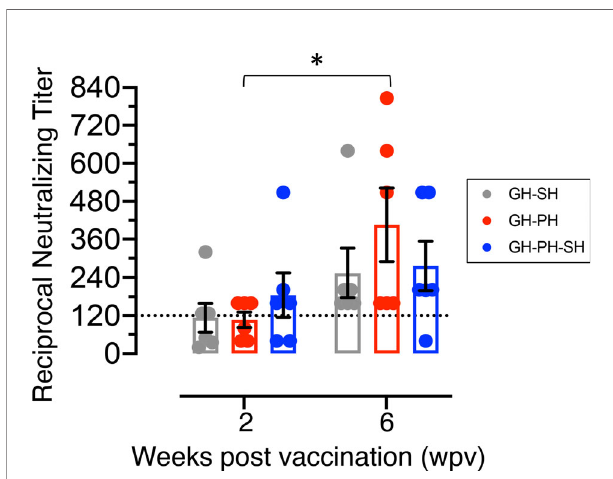
FIGURE 9 | Mean neutralizing antibody titers (mean ± standard error) of rhesus macaques vaccinated with canine distemper and measles vaccine were shown for GH-SH, GH-PH and GH-PH-SH groups. GH-PH animals demonstrated the highest neutralizing antibody response compared to the other groups at 6 weeks post vaccination (wpv). In contrast, GH-SH animals generated the lowest neutralizing antibody titers at 6 wpv, however the differences in responses were not statistically signi fi cant. Note, one animal from GH-PH-SH group had lower level of protective immunity (neutralizing titers 40) at 6 wpv time point compared to any group tested. Statistically signi fi cant differences were shown between pre and post vaccination timepoints in different housing groups (* represent P<0.05). The dotted line in the Y axis represents the accepted protective titer in humans